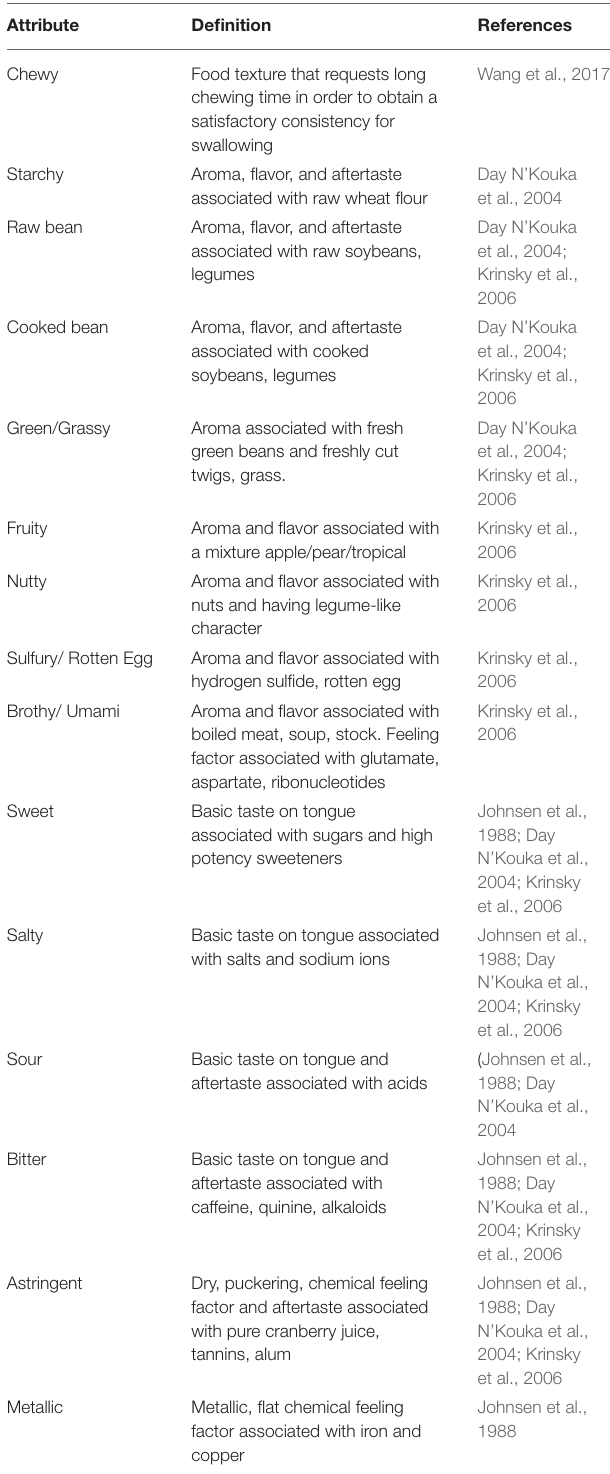
TABLE 1 | Check-All-That-Apply (CATA) list of sensory attributes for